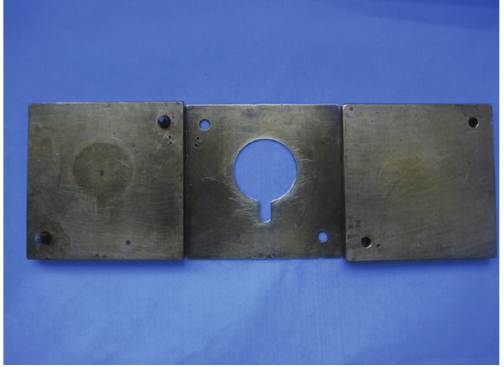
Figure 1: Three piece brass